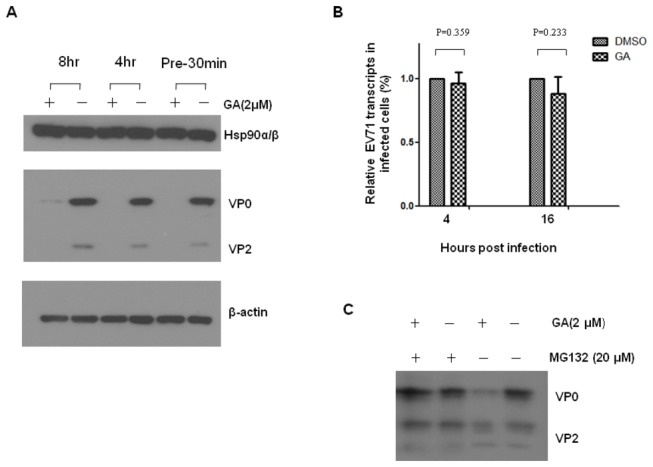
GA does not inhibit EV71 RNA transcription but accelerates the proteosomal degradation of de novo synthesized capsid proteins.RD cells were treated with 2 µM of GA by 30 min early of MOI= 0.01 of EV71 5746 infection and incubated for 16 hours in the presence of drug. Alternatively, cells were treated with GA at 4 or 8 hours post infection and then continued the incubation up to 16 hours. (A) Cell extracts were prepared to detect EV71 capsid or HSP90 proteins by immunoblotting with Mab979 antibody or anti-HSP90 antibody (N-17), respectively. Cellular β-actin was detected by blotting the same membrane with monoclonal anti-β-actin antibody. Data represent one of two independent experiments. (B) RNA were prepared at 4 and 16 hours post infection to quantify EV71 transcripts as described in the legend of Figure 4. Each β-actin normalized 2Ct value from GA-treated cells was ratio to the value from the value of 2Ct obtained from the vehicle-treated cells. (C) RD cells were treated with vehicle, or 2 µM of GA, or 20 µM of MG132 alone, or GA plus MG132, at 4 hours post EV71 infection and continued the incubation for 12 hours. The extracts were prepared to detect viral capsid proteins by Western blotting using Mab979 antibody. Data represent one of two independent experiments.